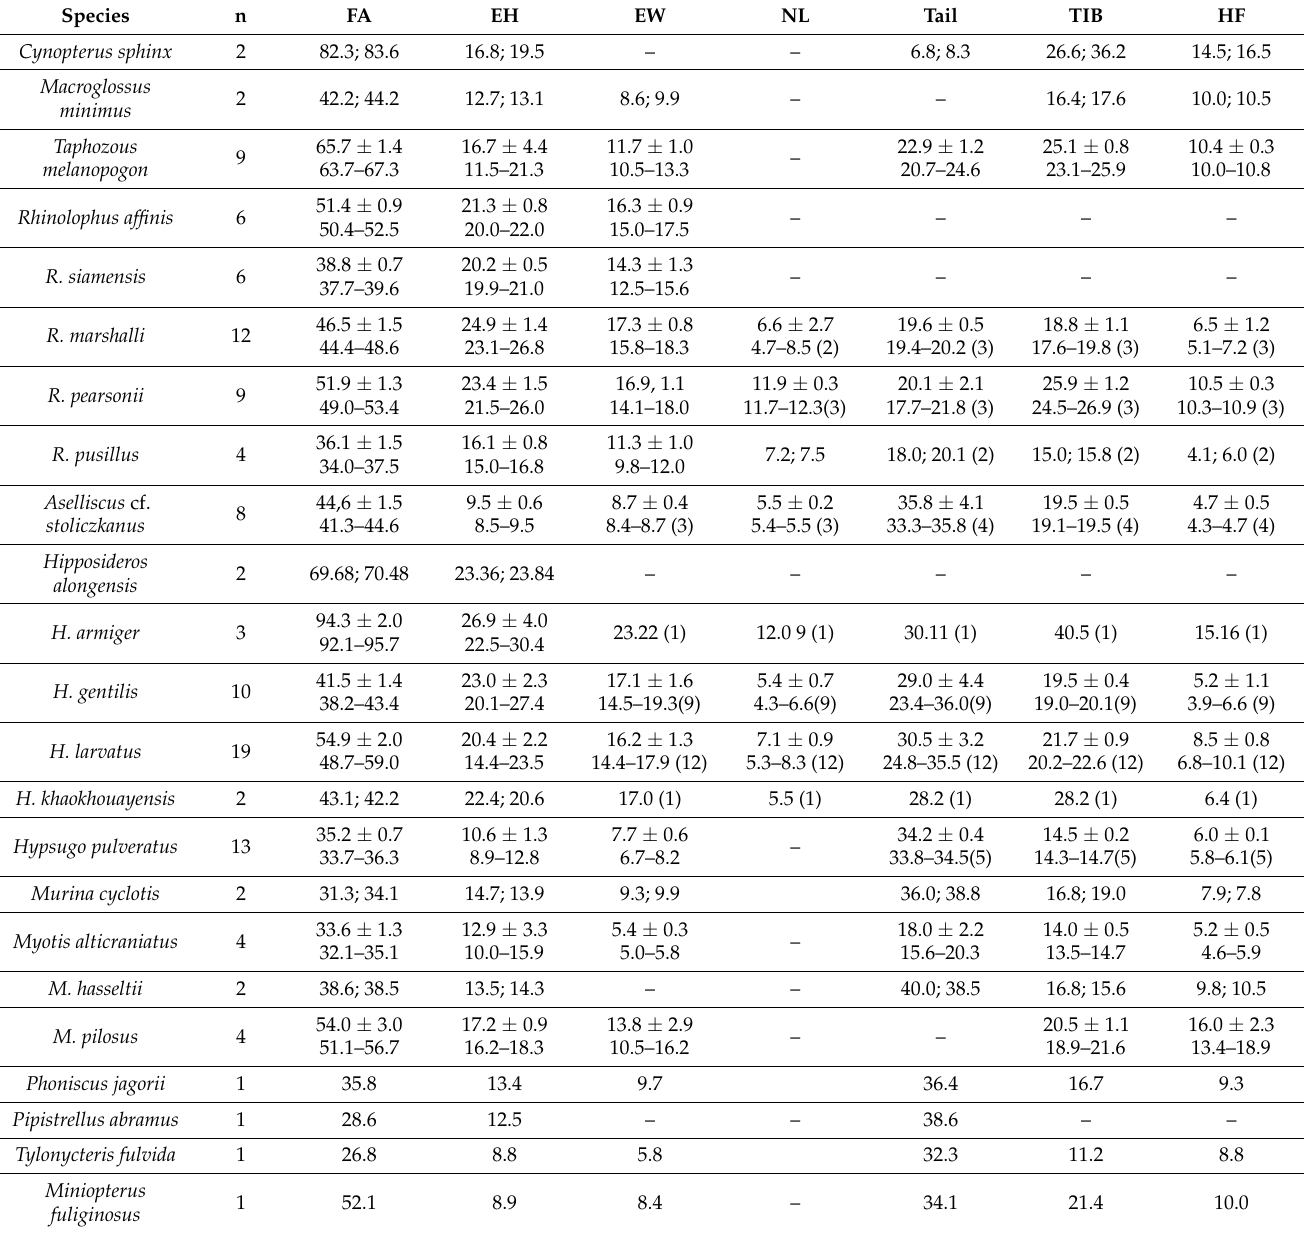
Table 2. Seven external measurements (in mm) of bat species recorded from Cat Ba Biosphere Reserve between 2015 and 2020. Abbreviations are defined in the Material and Methods section. Sample sizes differing from those reported under n are given in paratheses. Data are presented as a range (minimum and maximum) and mean and standard deviation are included when the sample size is ≥